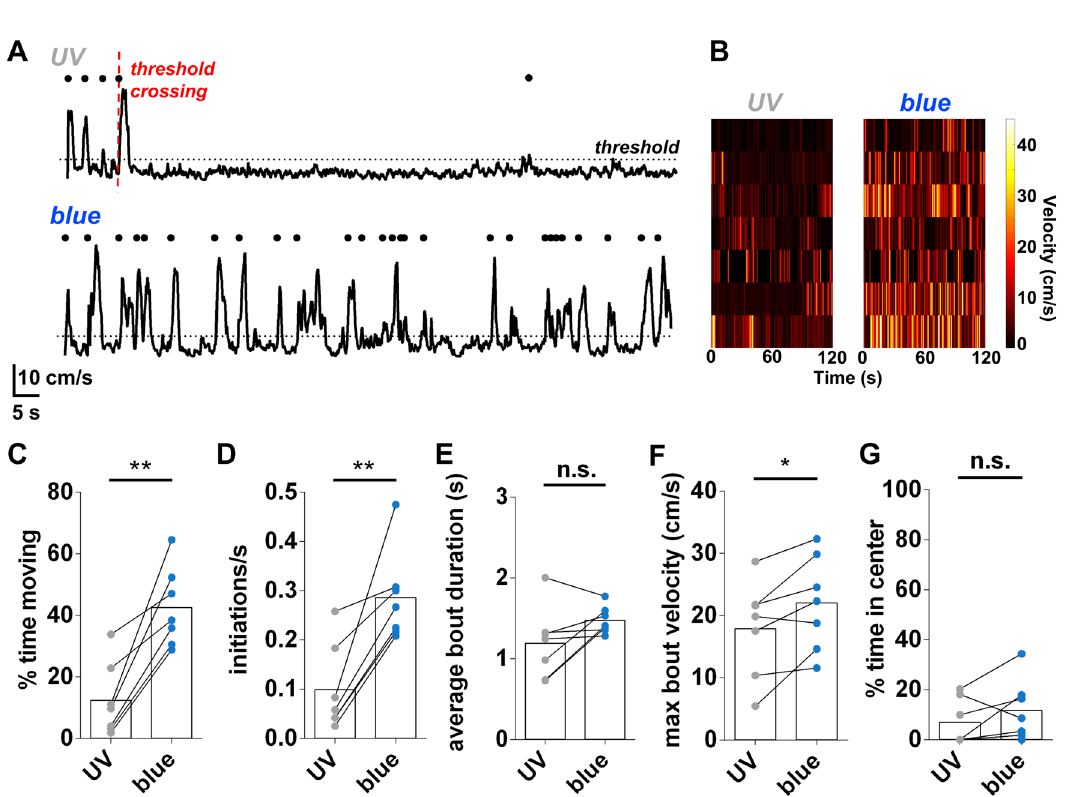
Fig. 4 dStr-dMSN D1R activation with MP-D1 ago enhances movement initiation but has no effect on movement duration. A Example movement dynamics of a mouse with MP-D1 ago in the inactive state (UV light; top panel ) and active state (blue light; bottom panel ), which correspond with the two- minute UV pre and blue periods described in Fig. 3f and Supplementary Fig. 15a. The dotted lines represent the velocity threshold used to identify movement bouts. Movement initiations are indicated by black circles. B Summary of the movement dynamics of mice with MP-D1 ago under UV light and blue light. Shown for MP-D1 ago mice is the effect of UV light and blue light on the C average percent of the time in motion, D average initiations per second, E average movement bout duration, F the average maximum movement bout velocity, and G percentage of the time that the mice were in the center of the open fi eld. paired two-tailed t-test, p -values from left to right: **0.001, **0.003, 0.080, *0.025, 0.214. n = 7 mice for each